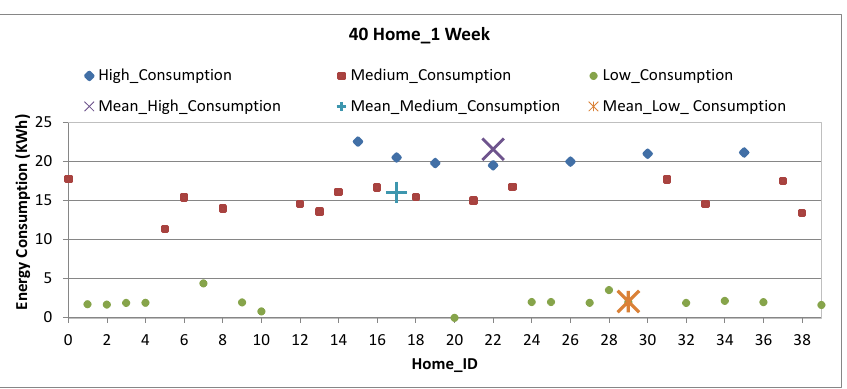
Figure 8. Results of one week cluster data